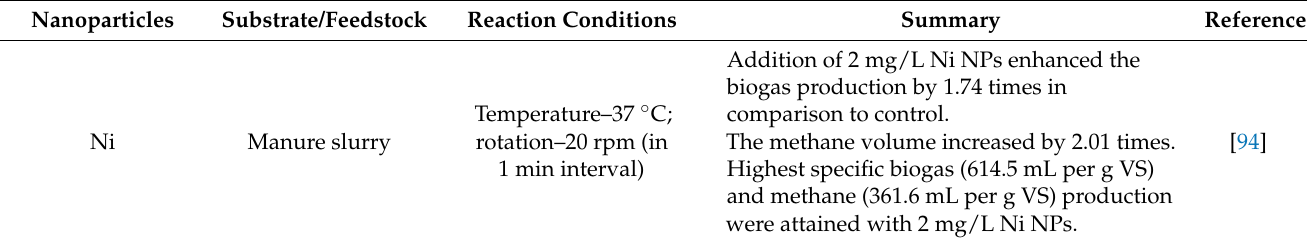
Table 2. Summary of application of nanoparticles in biogas production